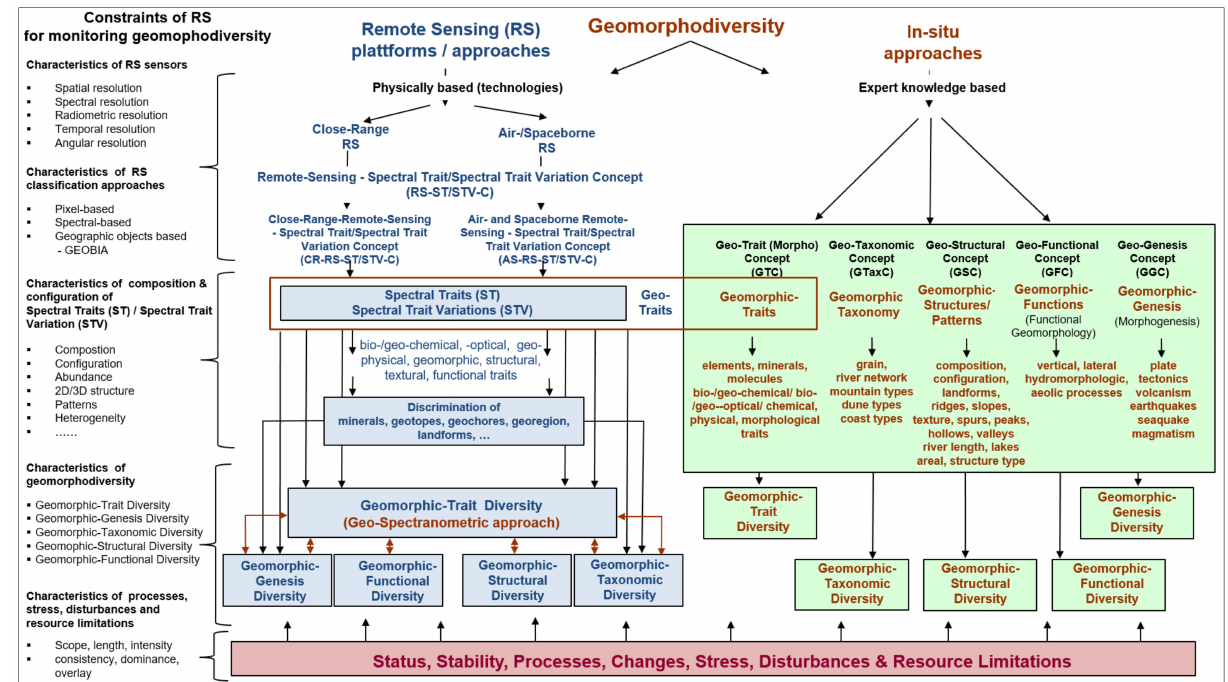
Figure 5. In situ and remote sensing (RS) approaches, common links, and the constraints of RS for monitoring the five characteristics of geomorphodiversity. Geomorphological traits are the crucial link between in situ and RS monitoring approaches (from Lausch et al.